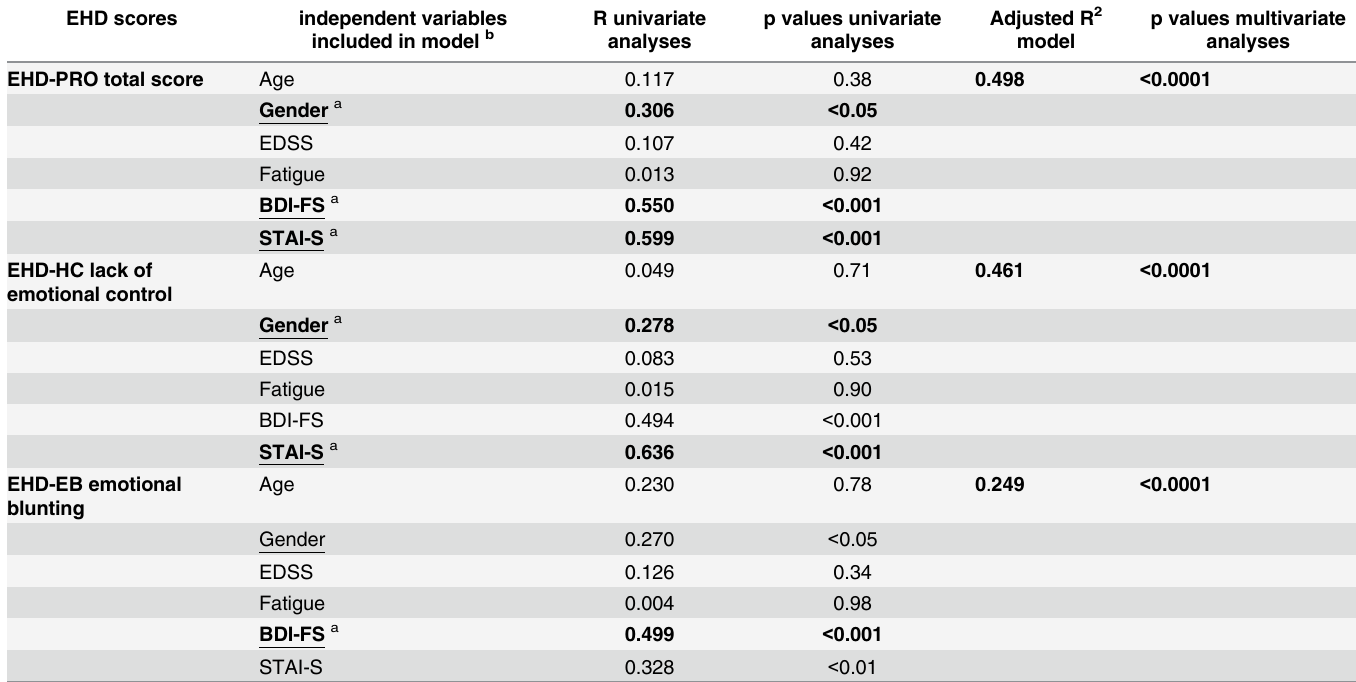
Table 2. Linear regression model describing EHD scores in